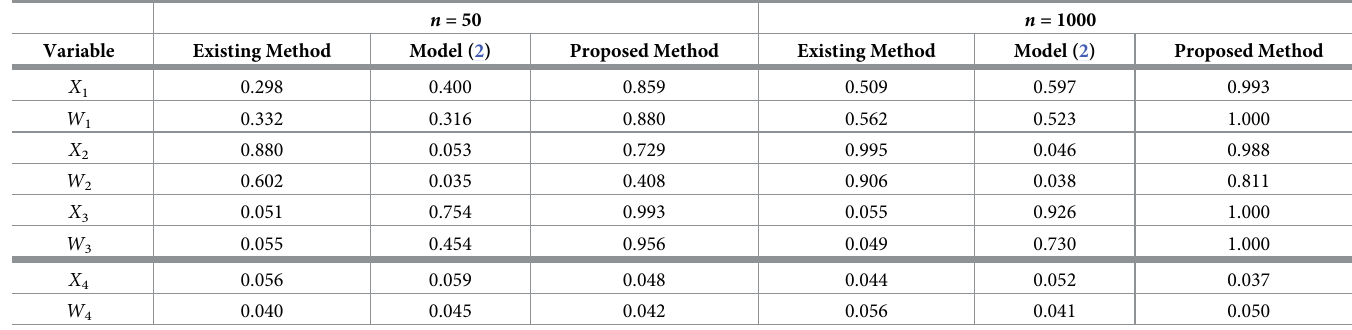
Table 3. Power and type I error comparison for cluster log-normal data ( ρ = 0).